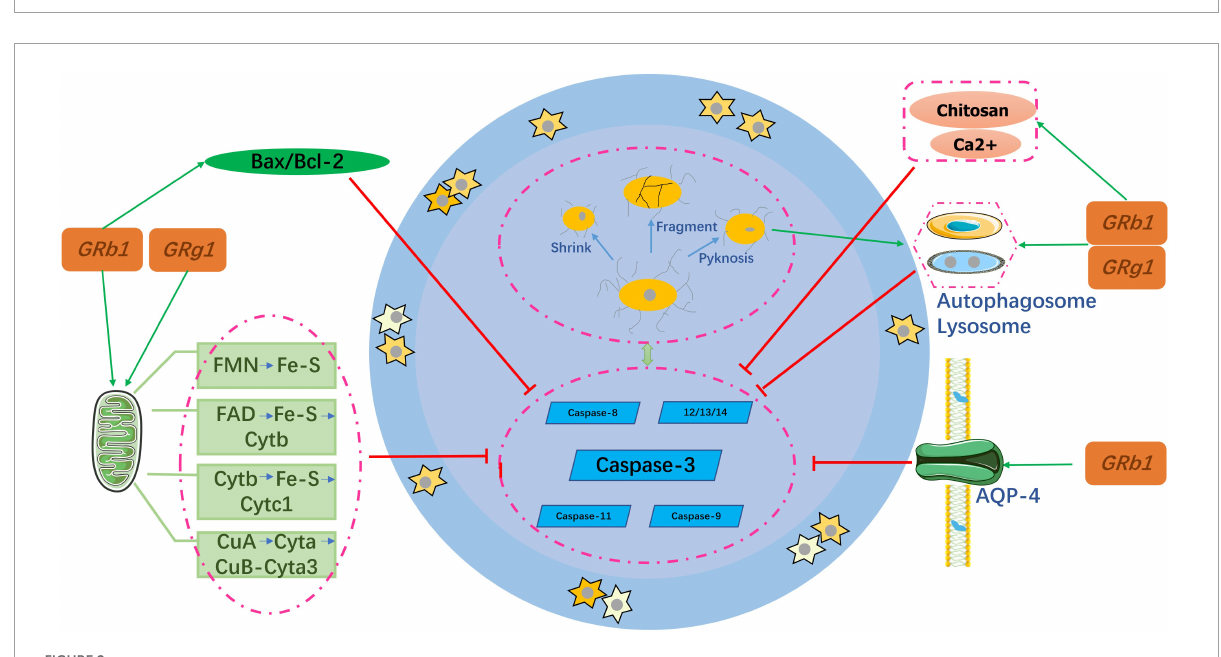
FIGURE2 Mechanism of the anti-inflammatory properties of ginsenosides.